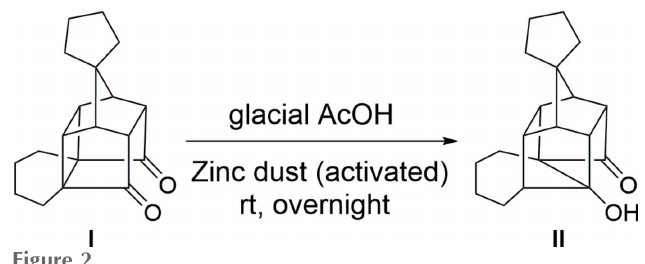
Figure 2 Reduction of cage propellane dione I with